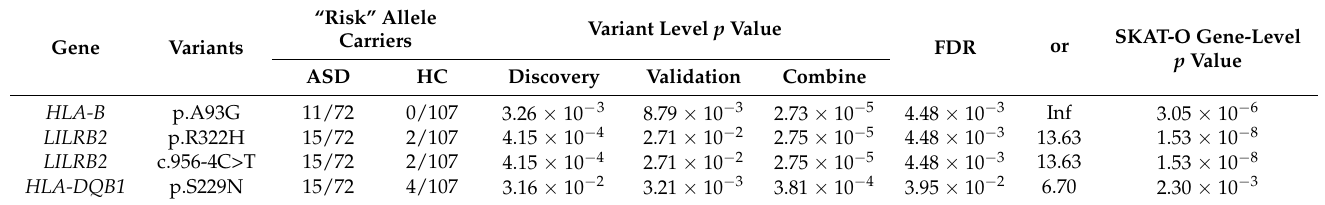
Table 1. Rare functional mutations in immune-response-molecule genes associated with